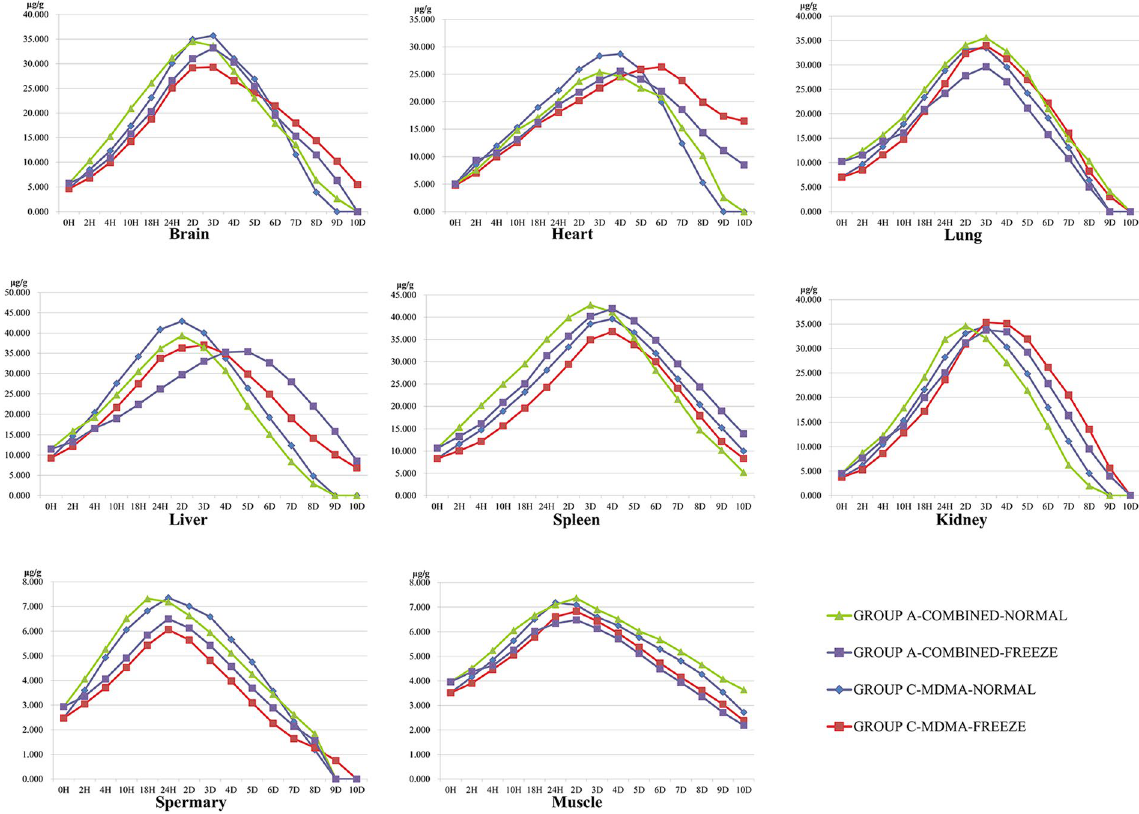
Figure 4. MDMA concentrations in tissues in 10 d.